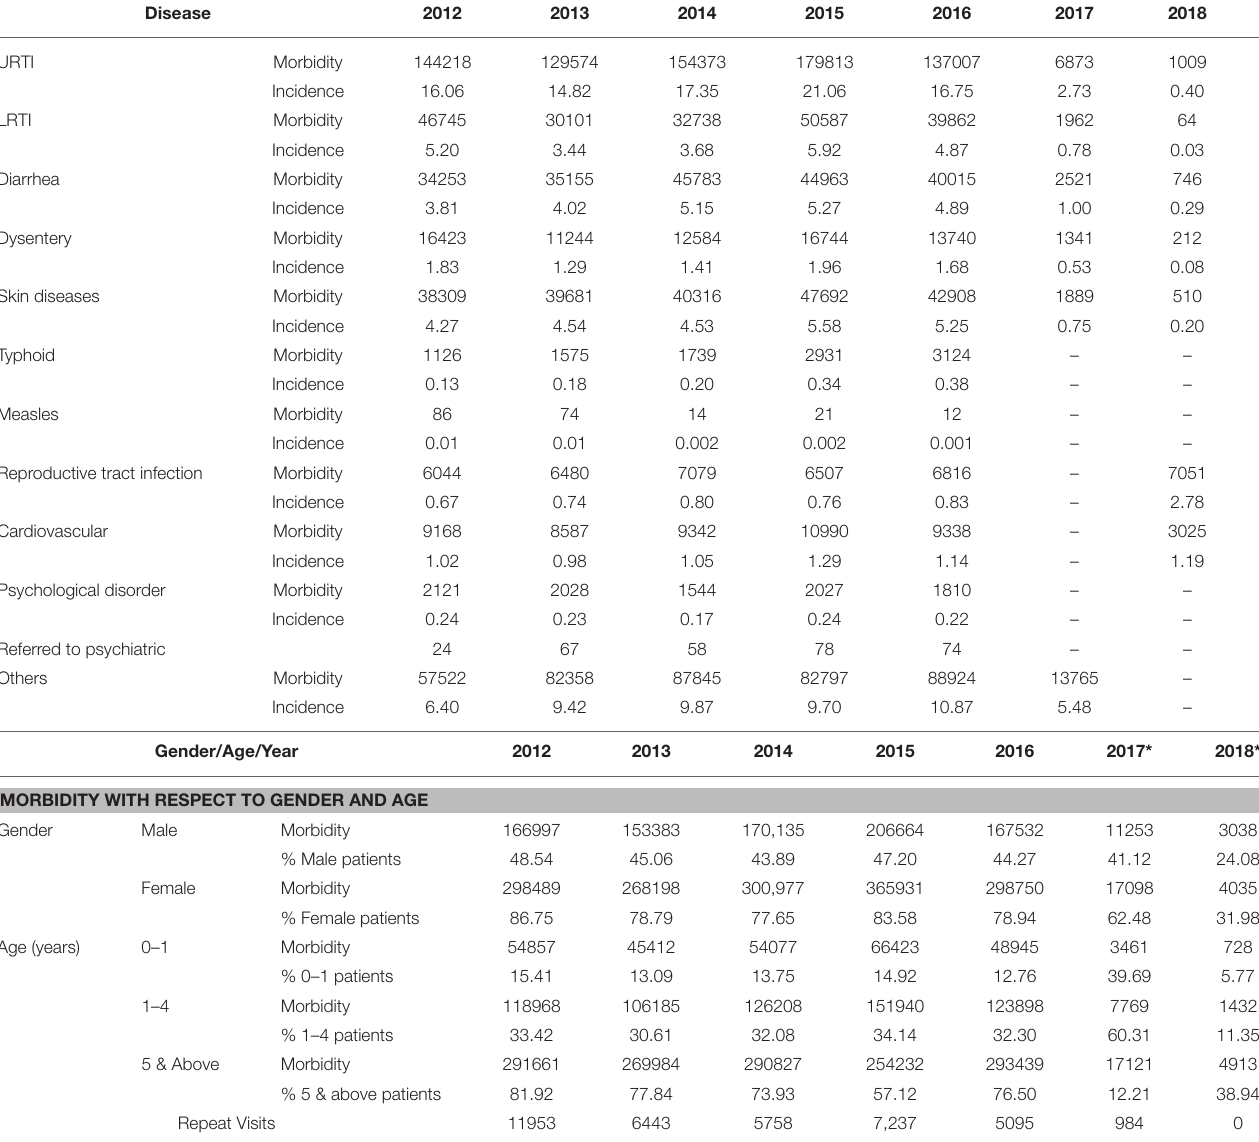
TABLE 2 | Disease morbidity of Afghan